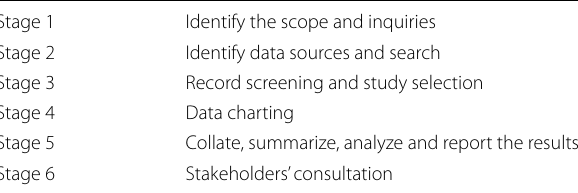
Table 1 Arksey and O’Malley 6-stage methodological